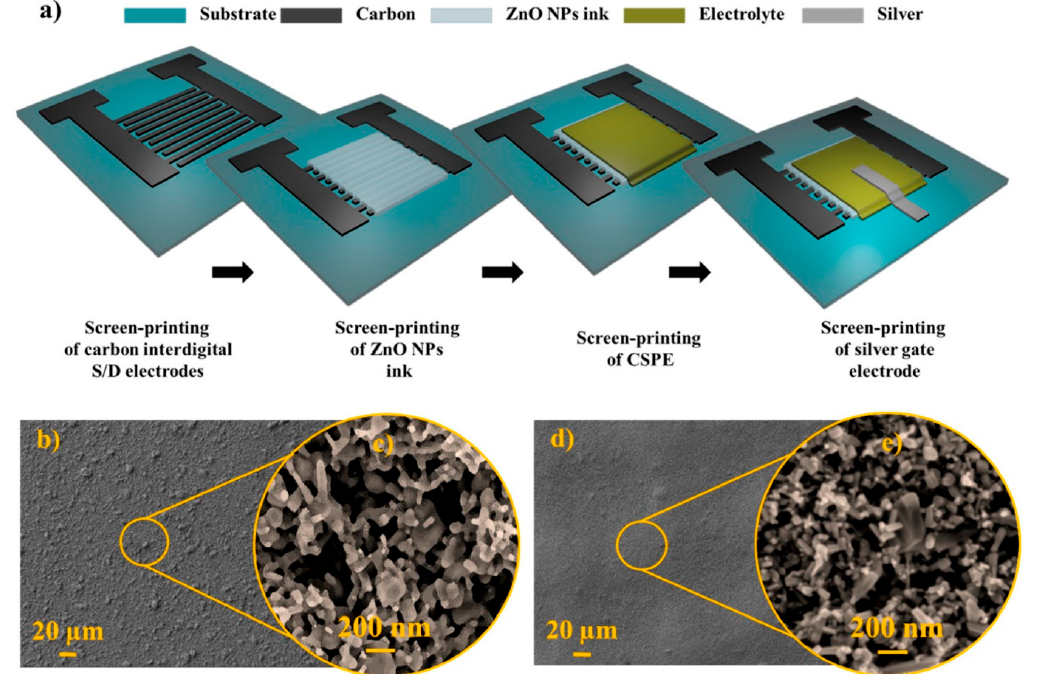
Figure10. ( a )SchematicrepresentationofthefabricationstepsforthefullyprintedZnOelectrolyte-gated Figure 10. ( a ) Schematic representation of the fabrication steps for the fully printed ZnO transistors (EGTs). ( b , c ) and ( d , e ) Topographical views of the screen-printed layers using two di ff erent electrolyte-gated transistors (EGTs). ( b, c ) and ( d, e ) Topographical views of the screen-printed layers ZnO inks. Reprinted from [173] under the CC BY 4.0 using two different ZnO inks. Reprinted from [173] under the CC BY 4.0 license.